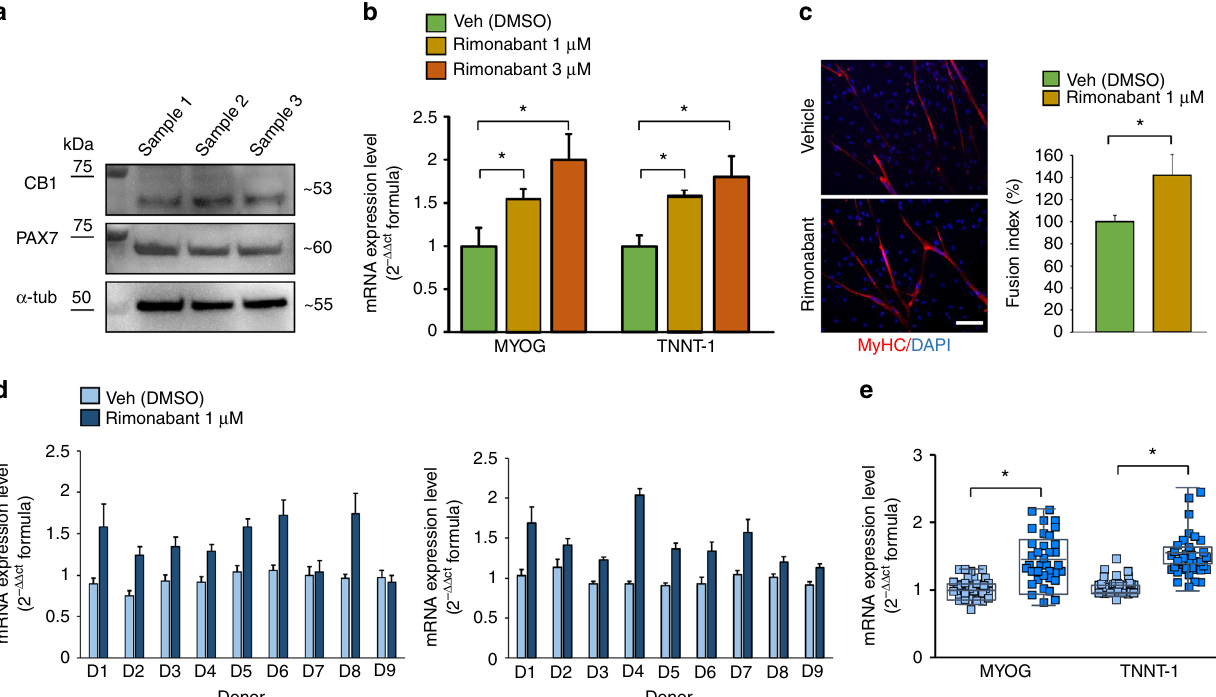
Fig. 5 Pharmacological role of CB1 in primary human muscle cells. a Representative blot for CB1 and PAX7 protein expression in primary human satellite cells. The approximate molecular mass for each of these proteins (expressed in kDa) is shown on the right. b Bar graph showing the mRNA expression levels of MYOG and TNNT-1 in satellite cells exposed to DM for 5 days + / − rimonabant 1 – 3 µ M. Each bar is the mean ± SEM of four separate determinations. c Morphological analysis of myotube formation in human primary satellite cells exposed to DM for 5 days in the presence of vehicle (DMSO, control) or rimonabant 1 µ M. MyHC (red) and DAPI (blue). (Scale bar, 10 μ m). The fusion index was calculated in both vehicle (DMSO)- and rimonabant-treated cells exposed to DM for 5 days. The asterisk denotes the P ≤ 0.05 vs. vehicle-treated cells. d Bar graphs showing the MYOG and TNNT-1 mRNA expression levels in primary human myoblasts isolated from each DMD donors (D1 – D9) and induced to differentiate in presence of vehicle (DMSO) or rimonabant (1 µ M). The quanti fi cation of transcripts was performed in quadruplicate by quantitative real-time PCR. The error bars correspond to the internal SEM. e The graph shows the differences in the expression levels of MYOG and TNNT-1 between vehicle- or rimonabant-treated myoblasts calculated by combining the DMD patient ’ s results together. Each bar is the mean ± SEM of the data from the nine patients, each of which was obtained from at least four separate determinations (see d ). * P ≤ 0.05 vs. vehicle group, determined by Student ’ s t